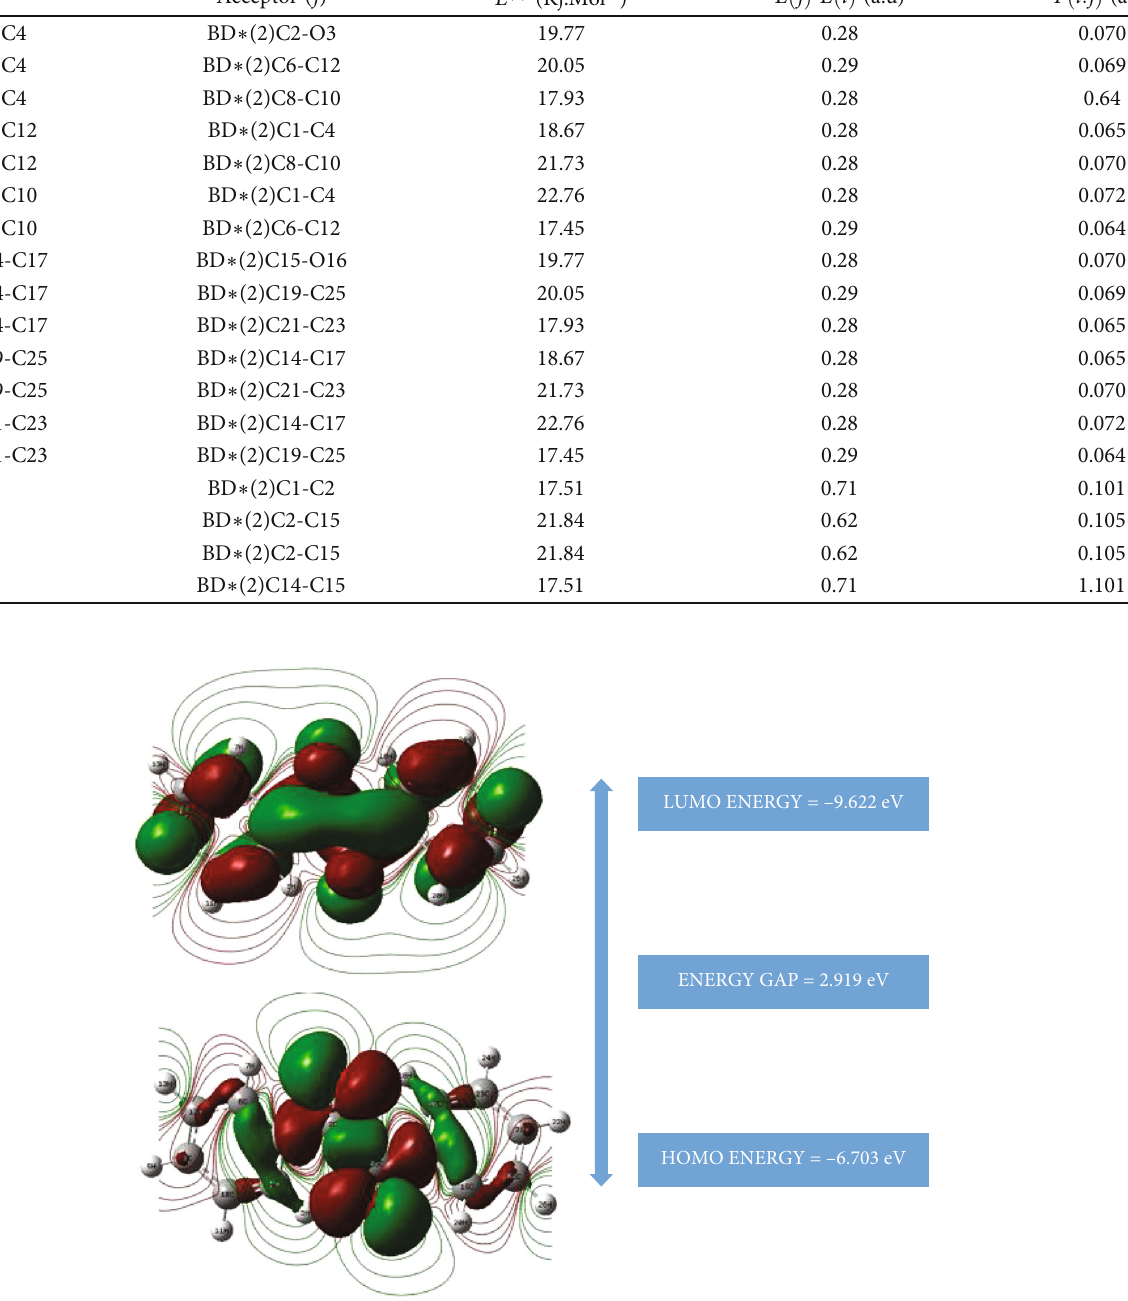
Table 3: Second-order perturbation theory analysis of the Fock matrix in NBO basis calculated at B3LYP/6-311G (d.p) level. Donor ( i )